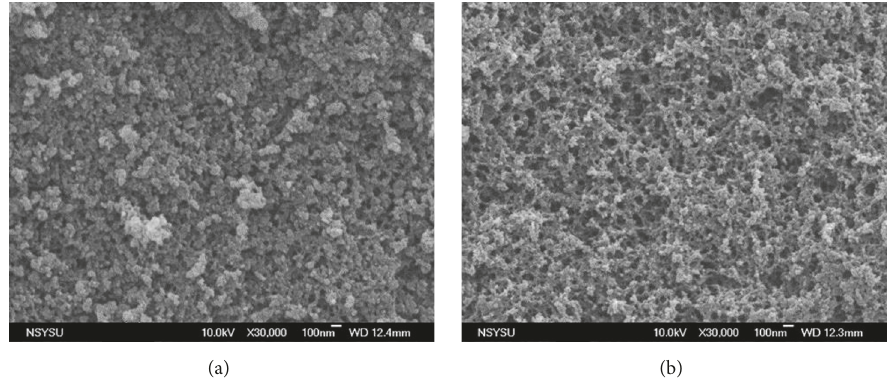
Figure 2: SEM images of (a) carbon xerogel CX and (b) activated carbon xerogel